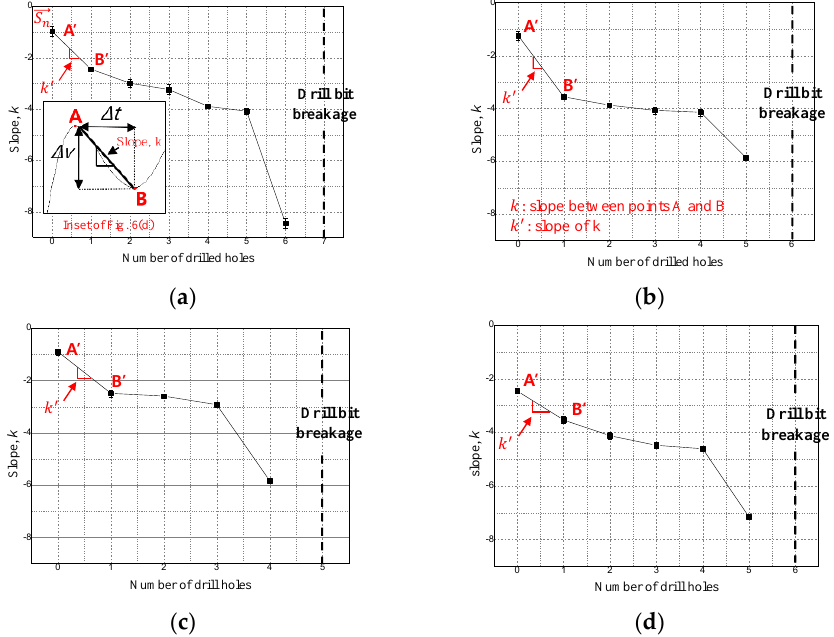
Figure 8. Slope between points A and B, k, from Figure 6d as a function of the number of drilled holes: ( a ) experiment condition 1, ( b ) experiment condition 2, ( c ) experiment condition 3, ( d ) experiment condition 4.